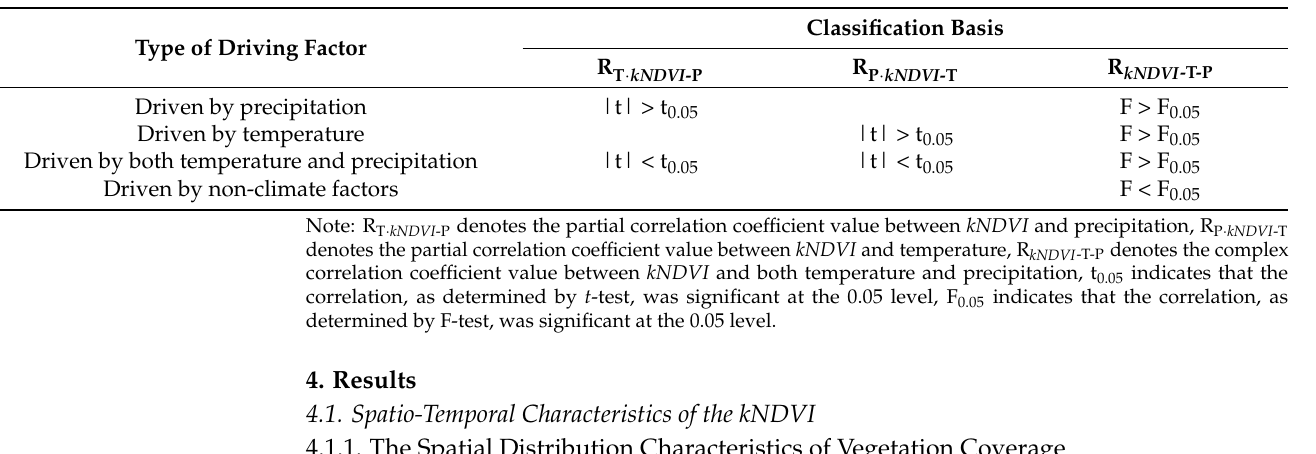
Table 1. Basis for the classification of climatic driving factors of dynamic change in the kNDVI